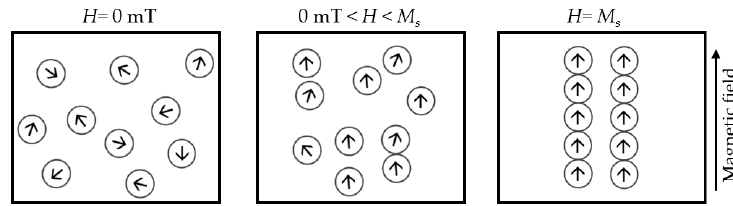
Figure 1. The behavior of the MF nanoparticles under different magnetic field intensities.